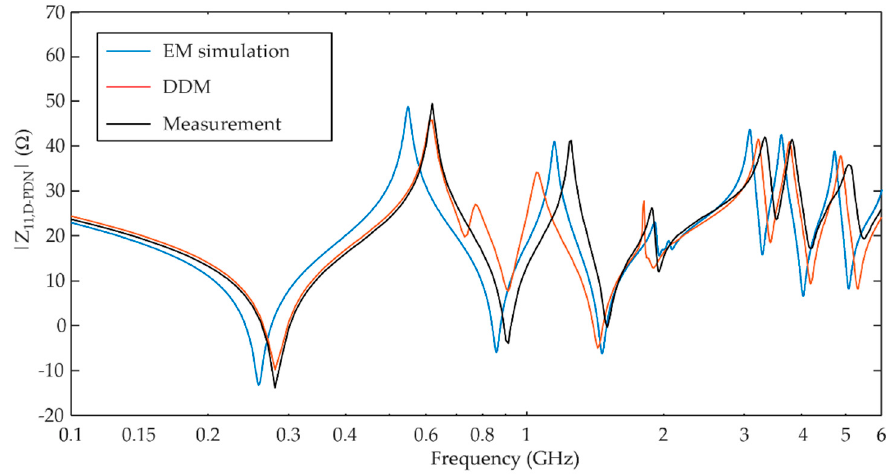
Figure 16. DDM validation by comparing the results of DDM, EM simulation, and measurements.